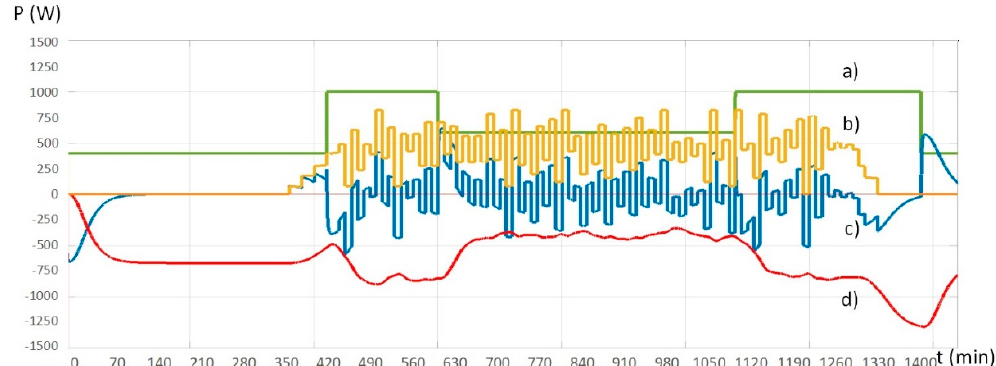
Figure 15. Simulation process for cloudy day conditions. Storage system filter with damping ratio ζ = 0.1: ( a ) the PV plant production, ( b ) the power required by the consumer, ( c ) the battery storage power and ( d ) the supercapacitor power.